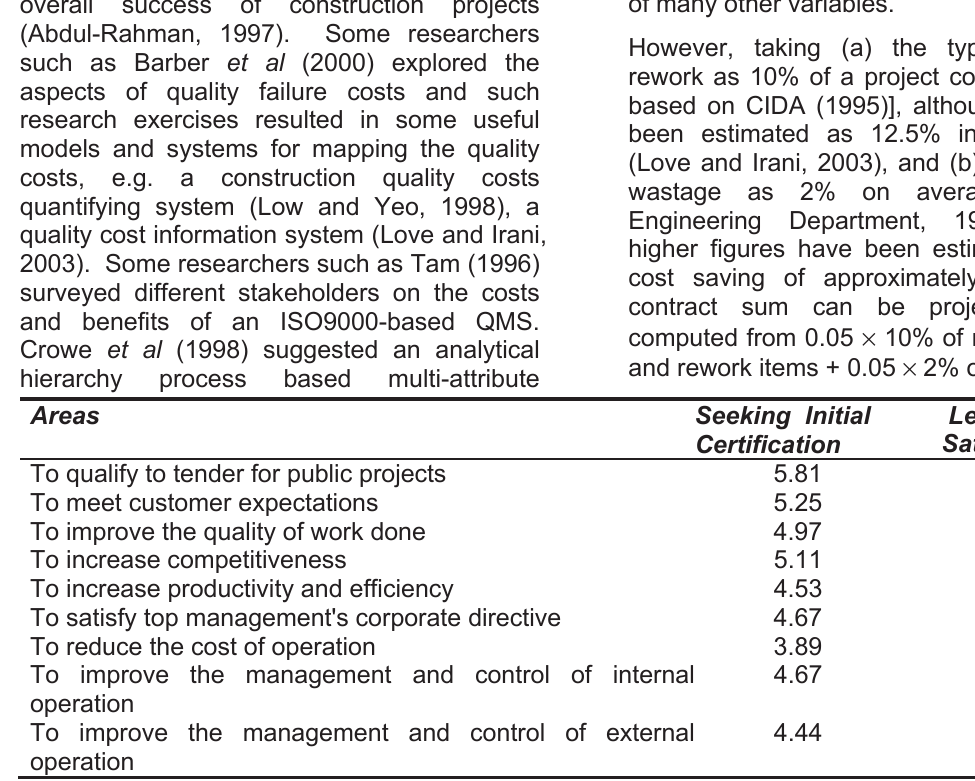
Table 1: Reasons for implementing ISO9000-based